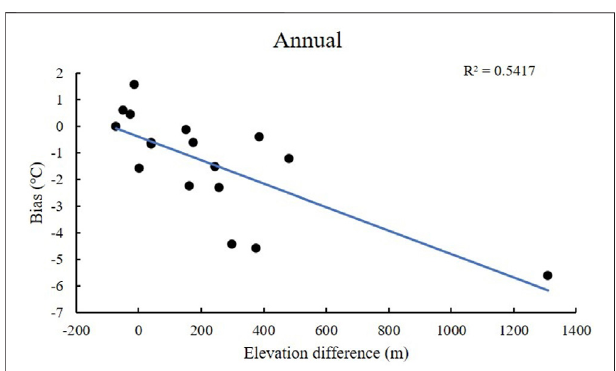
FIGURE 7 | Relationship of bias and elevation differences between monthly observations and ERA5-Land during the 1979 – 2017 period.